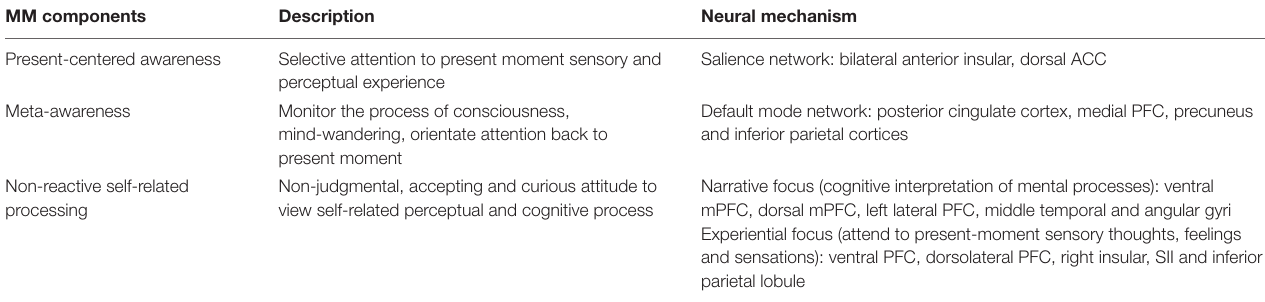
TABLE 1 | The description of mindfulness meditation (MM) components and neural